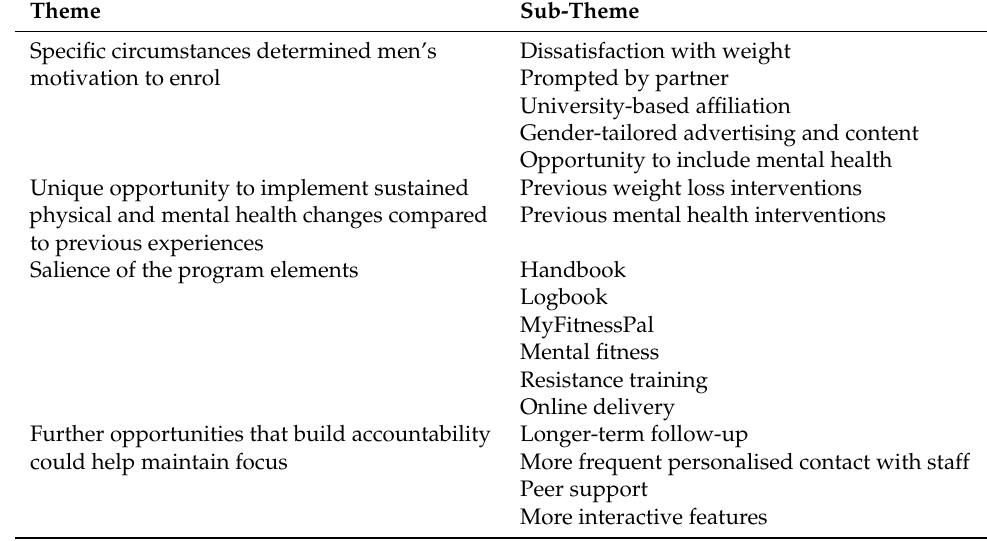
Table 3. Themes and sub-themes emerging from the interview with men participating in the SHED-IT: Recharge